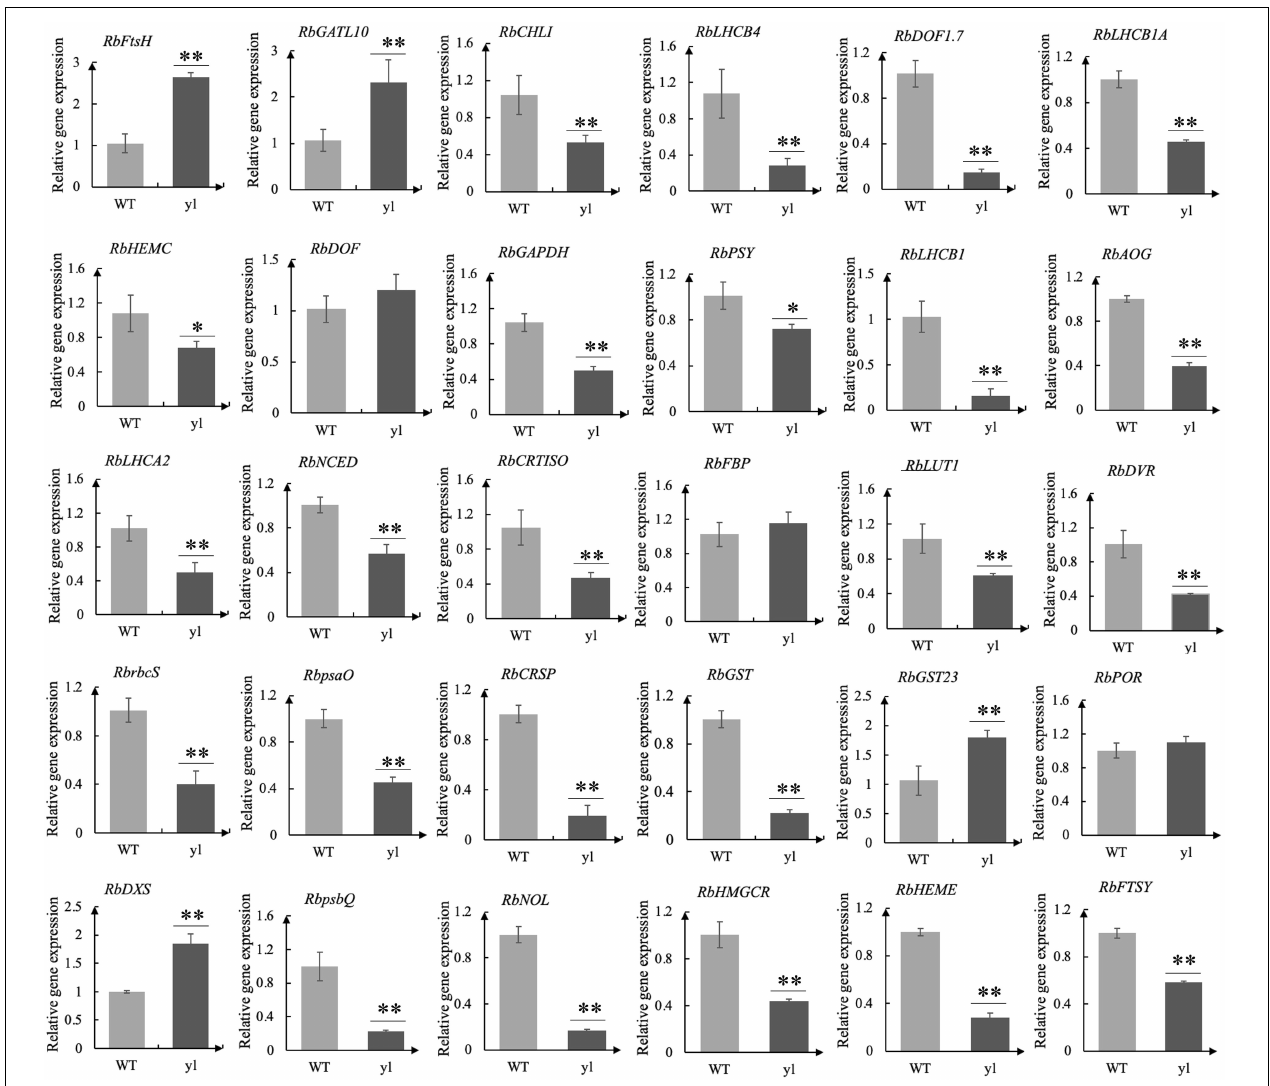
FIGURE 3 | Real-time quantitative PCR (qRT-PCR) analysis for 30 differentially expressed genes (DEGs). The qRT-PCR were performed for three biological replicates and three technical repetitions. ∗∗ indicates very significant difference of gene expression at 0.01 level. ∗ indicates significant difference of gene expression at 0.05